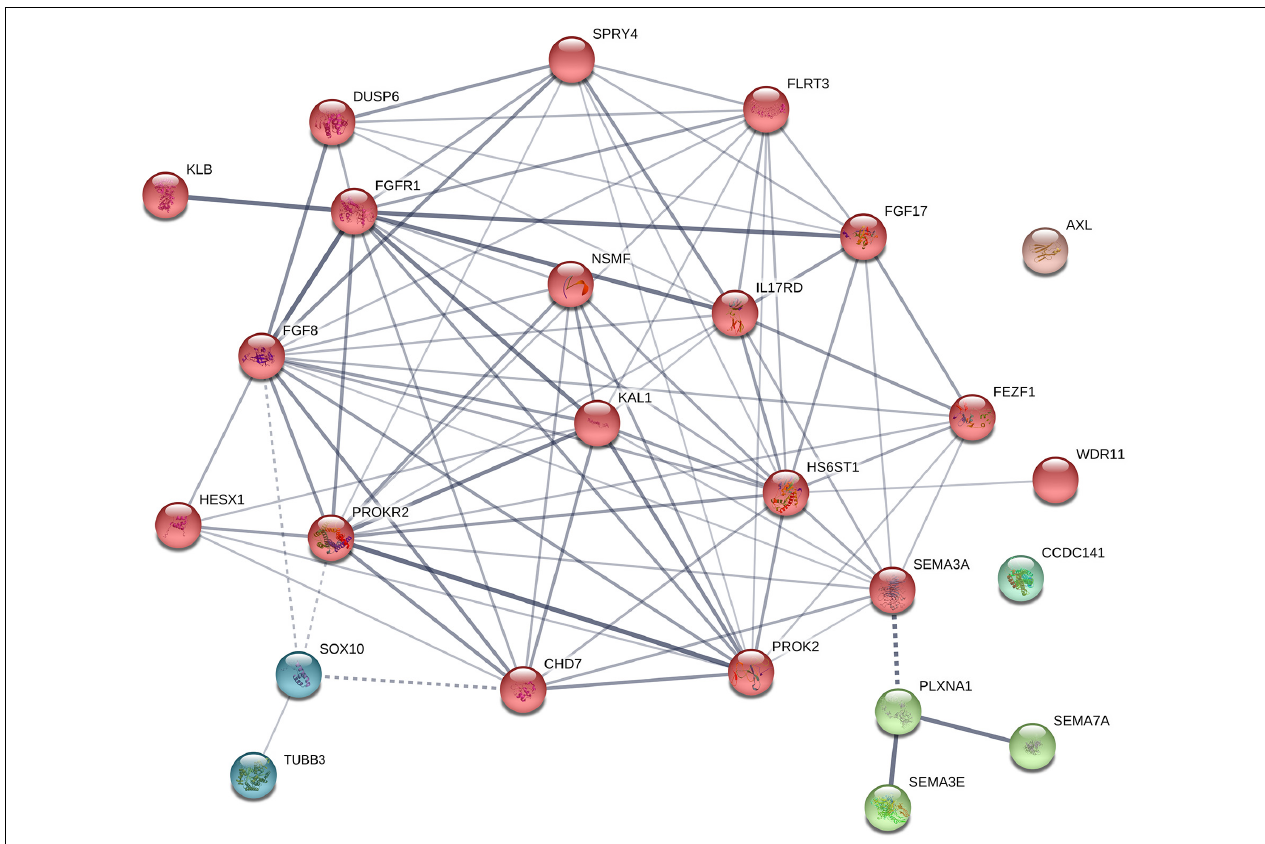
FIGURE 5 | Protein–protein interaction network in known genes of KS. The diagram shows known and predicted interactions among KS causative genes listed in Table 2 , created using String software version 11.0 with minimal confidence score of 0.4. Total 87 lines (interactions) appeared across 25 nodes. The colored nodes symbolize proteins which clustered by MCL algorithm. The thickness of the line represents confidence of protein–protein associations (with score 0.4, 0.7, and 0.9, relatively). Solid line, interactions within a cluster; Dotted line, interactions between clusters.